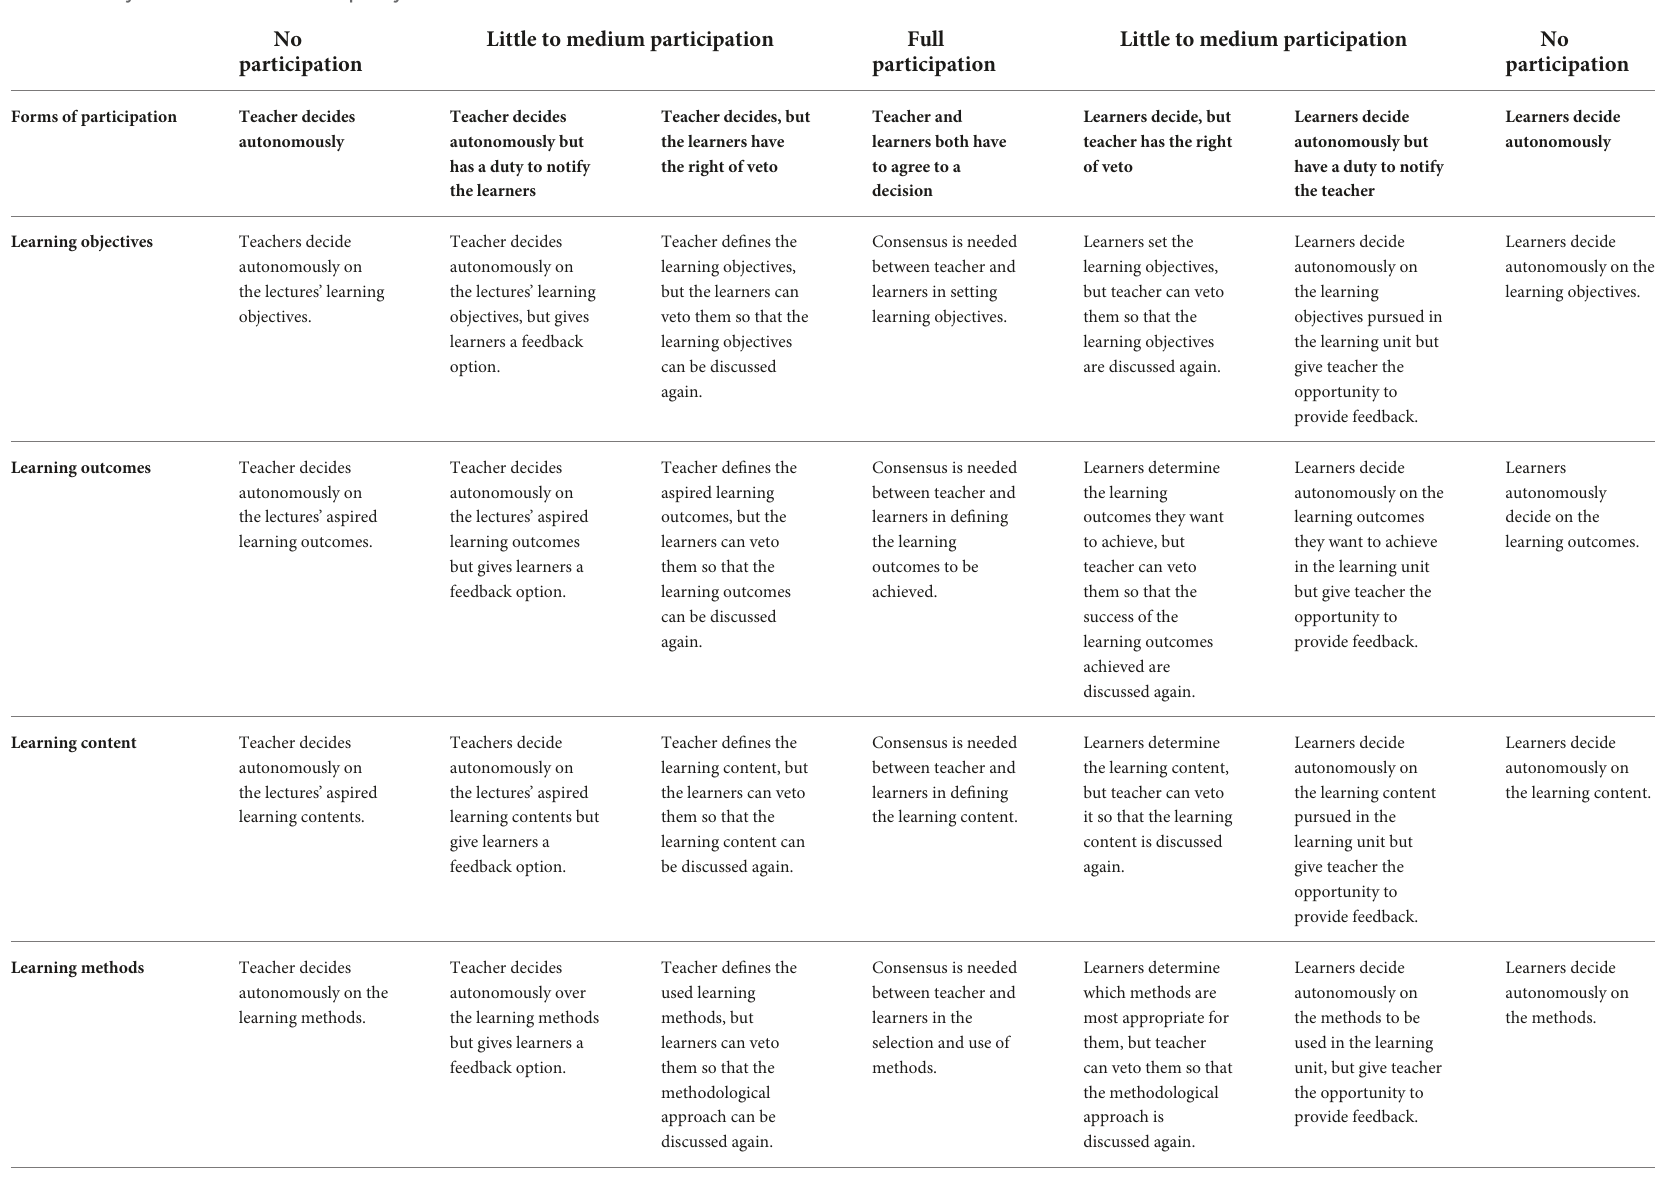
TABLE 3 Analytical framework for Participatory Educational Practices